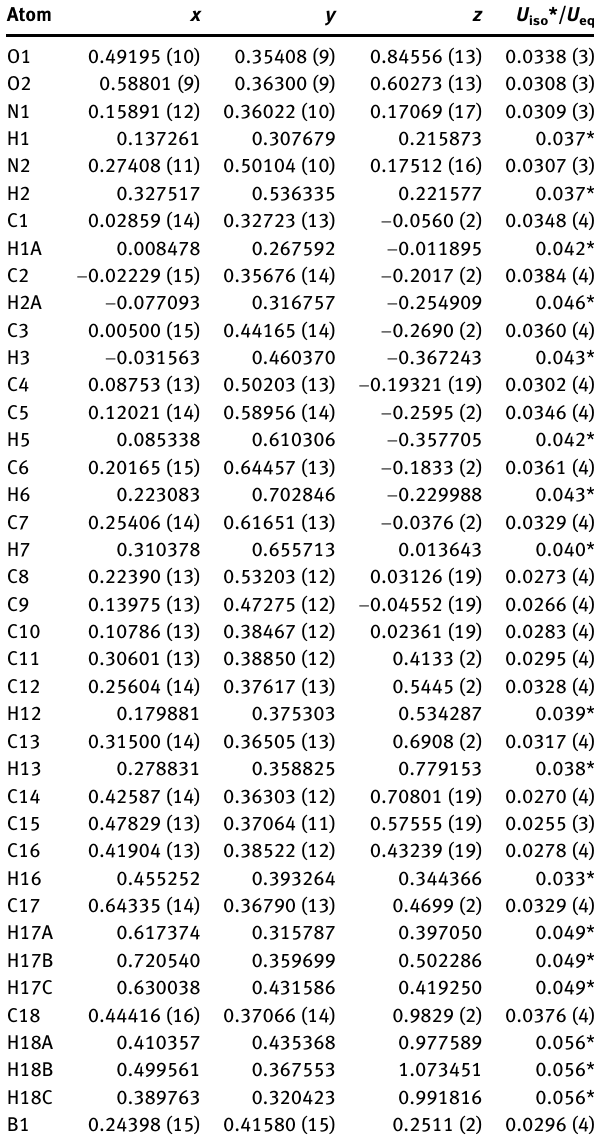
Table  : Fractional atomic coordinates and isotropic or equivalent isotropic displacement parameters (Å 